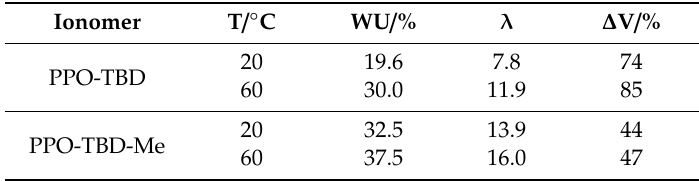
Table 1. Gravimetric water uptake WU, hydration numbers λ and volumetric swelling ∆ V after 48 h in H 2 O at 20 and 60 °C of PPO-TBD and PPO-TBD-Me.